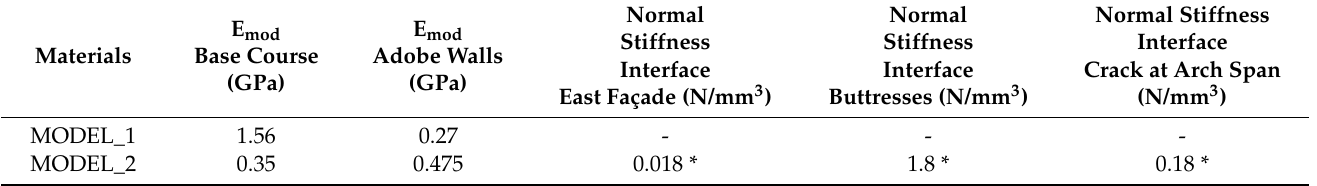
Table 4. Preliminary material properties in the elastic range for MODEL_1 and MODEL_2.